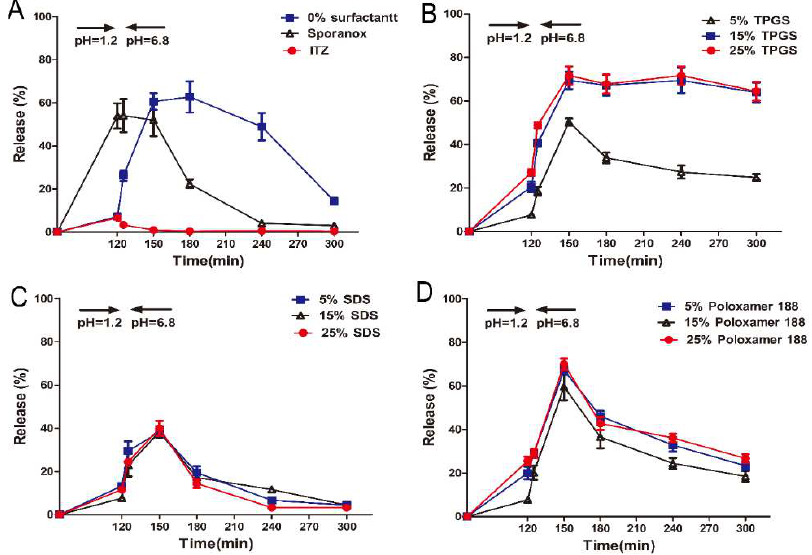
Figure 2. In vitro release profiles of ITZ from different formulations in simulated gastrointestinal fluid (Mean ± S.D., n = 3). ( A ) In vitro release profiles of ITZ from pure ITZ, Sporanox ® , and ASD (amorphous solid dispersion) without surfactant; In vitro release profiles of ITZ from ASD with different amount of ( B ) TPGS ( D -α-tocopheryl polyethylene glycol 1000 succinate), ( C ) SDS (sodium dodecyl sulfate), and ( D ) Poloxamer 188.